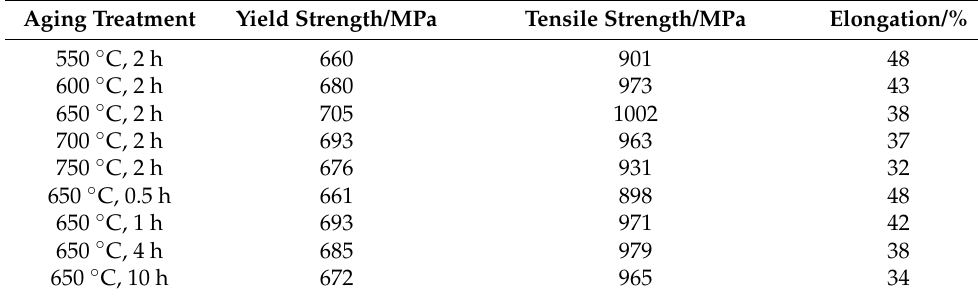
Figure 7. Stress-strain curve of the experimental steel after different aging treatment. ( a ) different temperatures with 2 h, ( b ) 650 °C with different time. Table 2. Tensile properties of the experimental steel after different aging treatment.